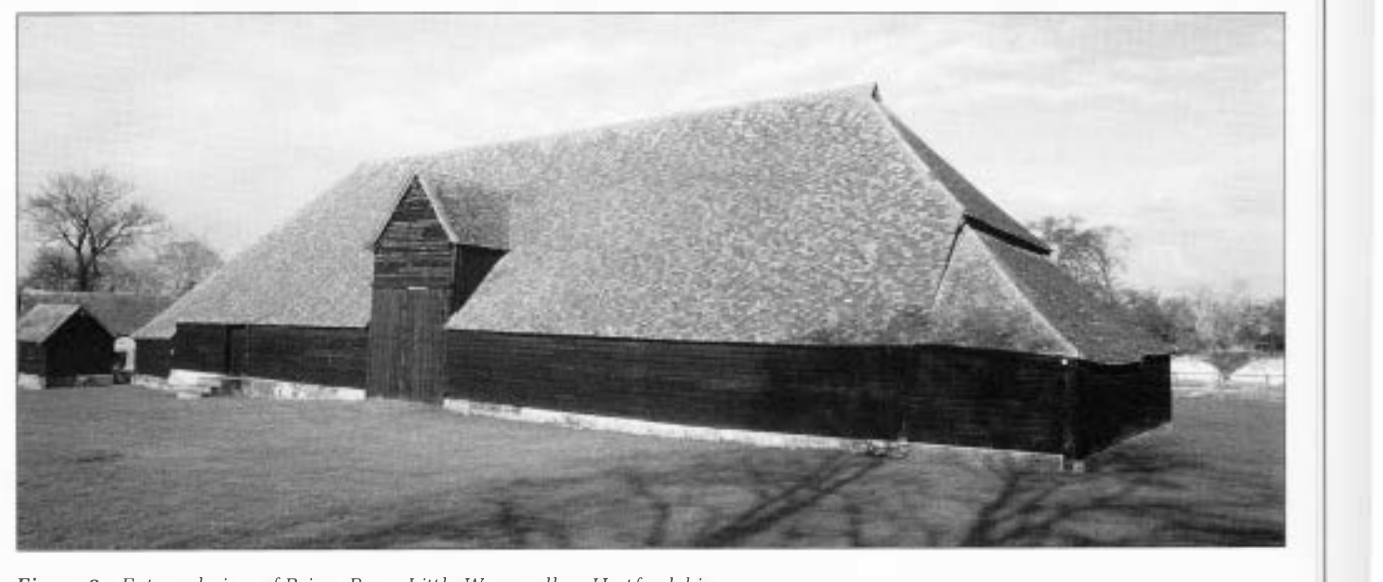
Figure 3 External view of Priory Barn, Little Wymondley,